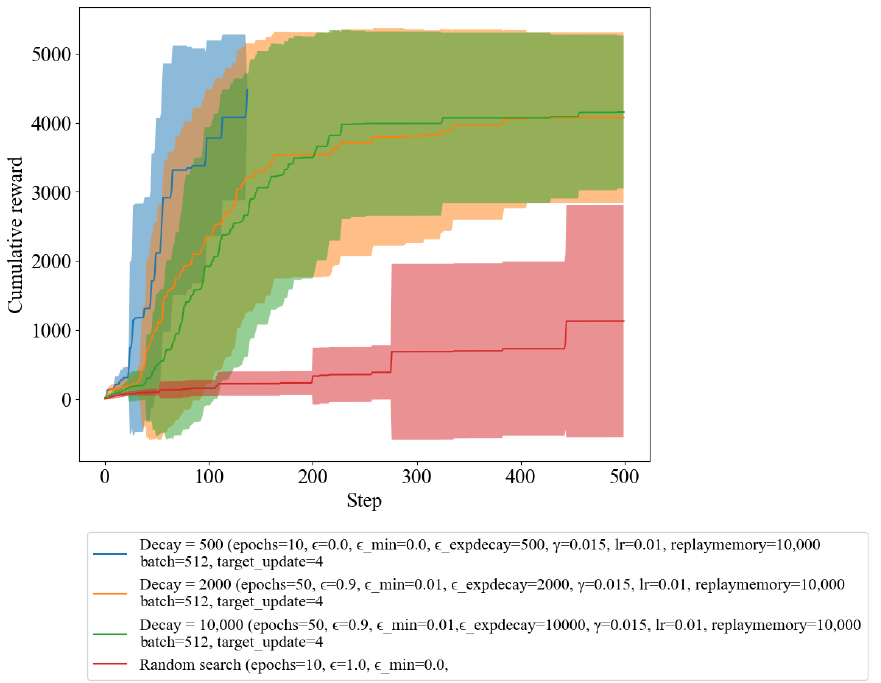
Figure 5. Reward of random search and DQL with varying epsilon decay.